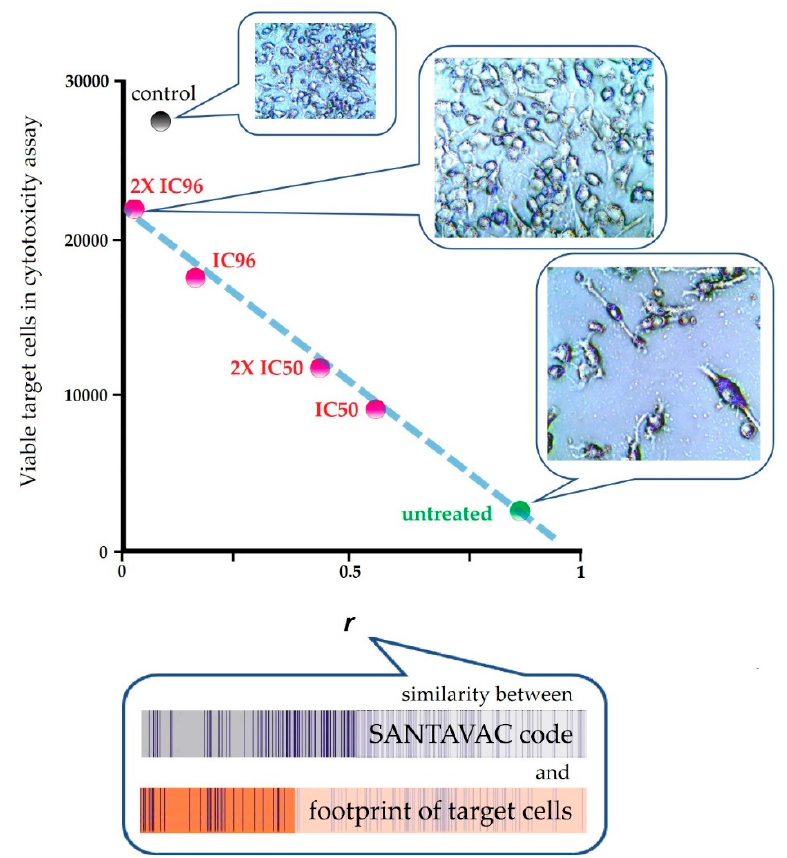
Figure 4. Escape of cancer cells from the SANTAVAC-mediated immune response in CTA as a result of cell surface profile changes induced by the selective pressure of drug treatment. Points are presented for MCF-7 target cells that were untreated or treated with either a single dose of IC96 or IC50 etoposide or two separate doses (‘2X’) of IC96 or IC50 etoposide. Linear approximations for points related to MCF-7 cells are shown. Tested SANTAVAC consists of surface antigens of untreated MCF-7 cells. The average number of viable cells in three wells is presented. Correlation coefficients ( r ) were calculated for SANTAVAC code and footprints of target cells (i.e., SANTAVAC/target similarity). ‘Control’ corresponds to SANTAVAC produced from HepG2 cells. Adapted from [51].